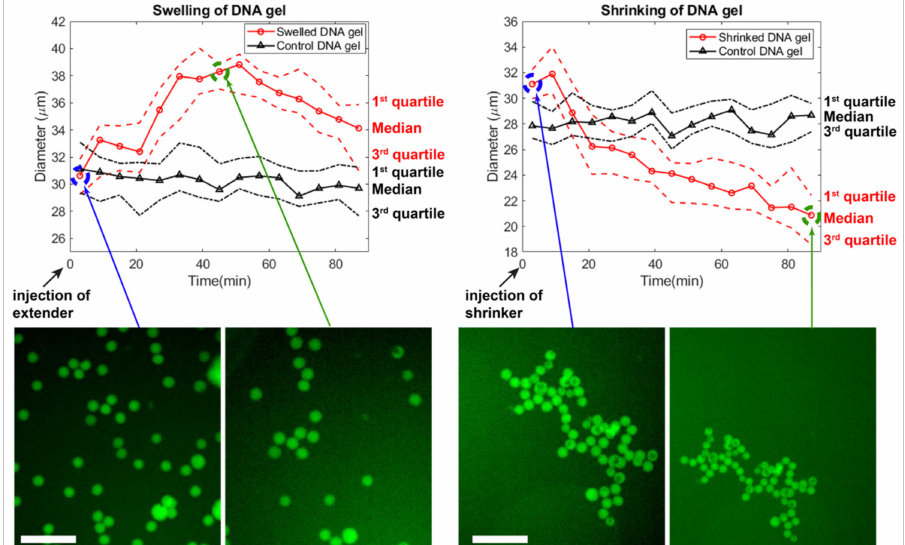
Figure 7. Time-course of the swelling and shrinking of DNA gels. Extender or shrinker strands are added at the beginning, and the distribution of beads’ diameter is followed by microscopy. For each frame, 25 beads were chosen at random in the field of view, excluding large outlier beads. After 90 min, the shrinker strand was injected and beads in a different field of view were followed. The scale bar is 150 µ